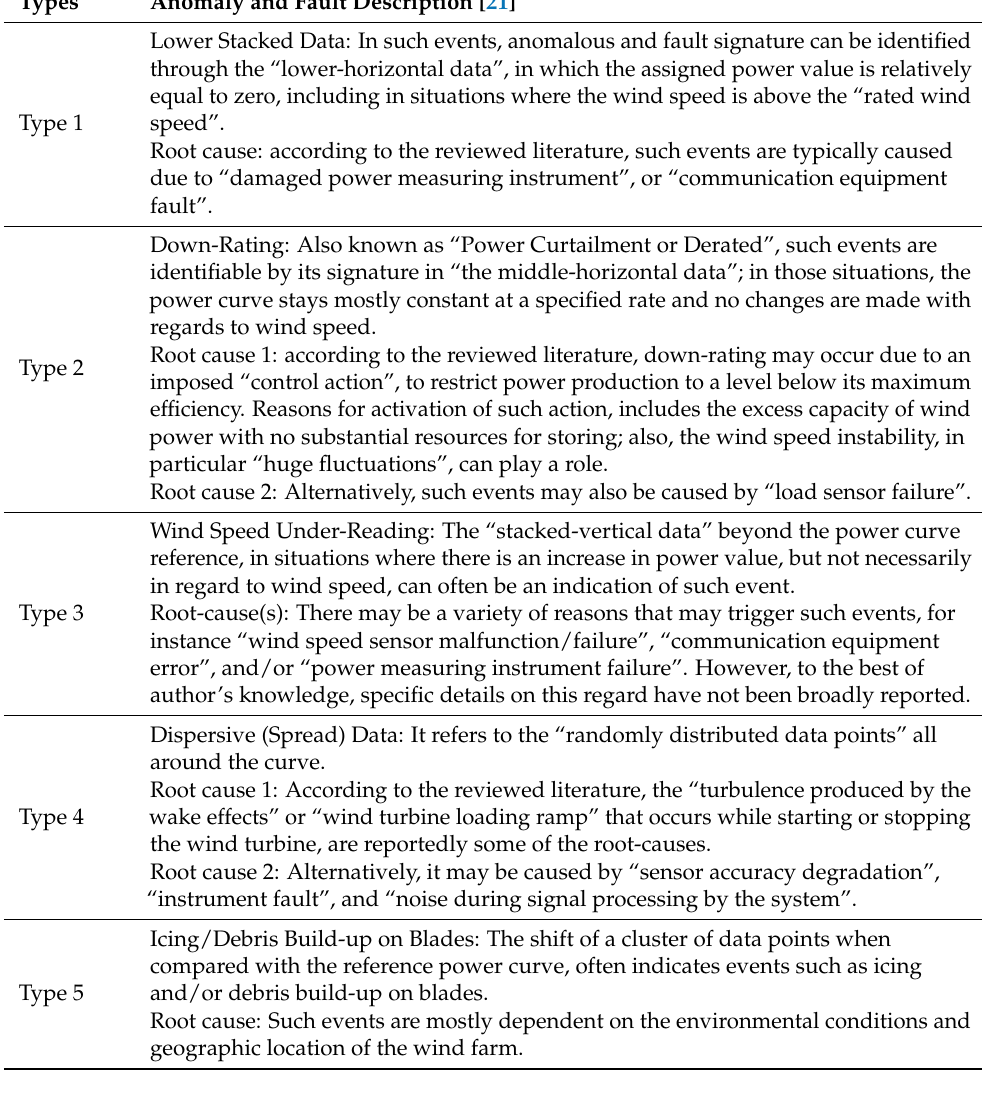
Figure 6. Type 1: Lower Stacked Data.